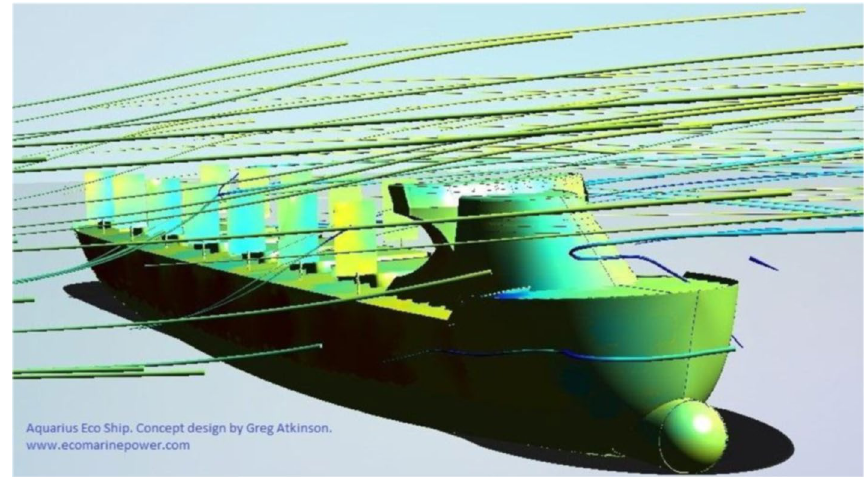
Fig. 3 Analysis of airflow around rigid sails on Aquarius Eco Ship concept design (source: Wikimedia Commons, the image is used under a CC BY-SA 4.0 license)